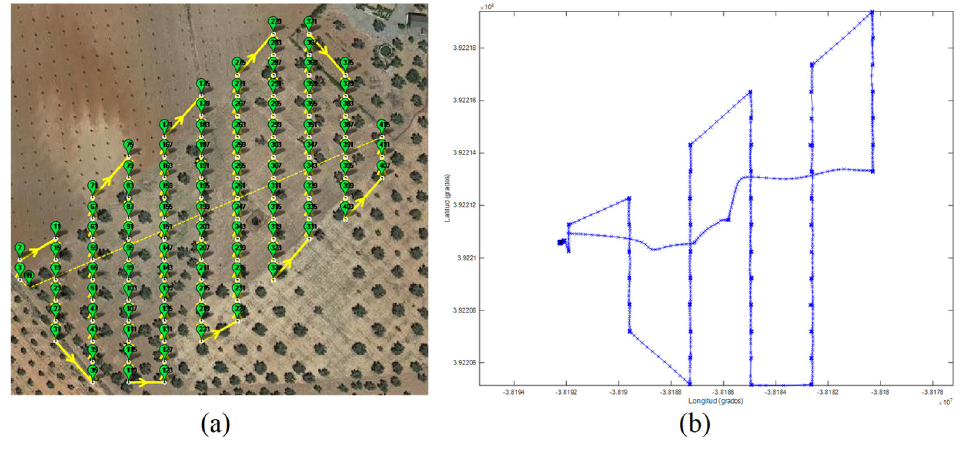
Figure 16. ( a ) A mission visualized in Mission-Planner program. ( b ) The actual sub-route recording UAV real GPS waypoints.